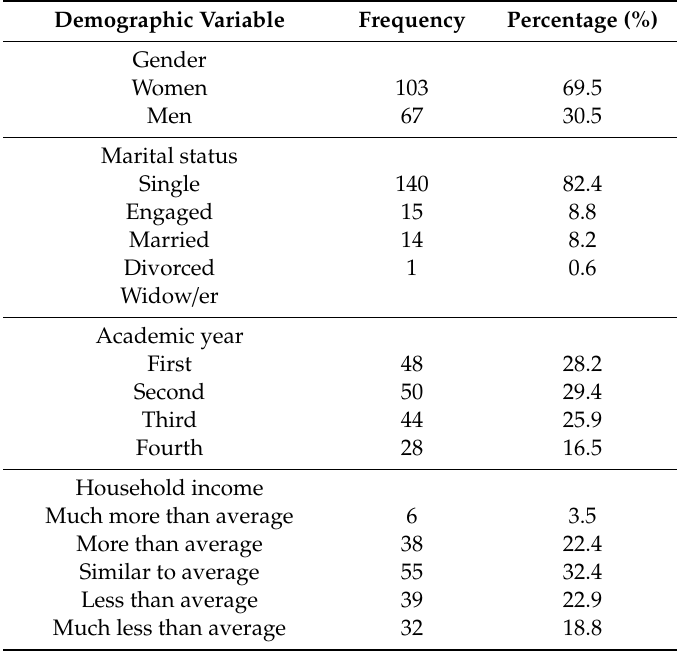
Table 1. Frequencies and percentages of demographic variables.